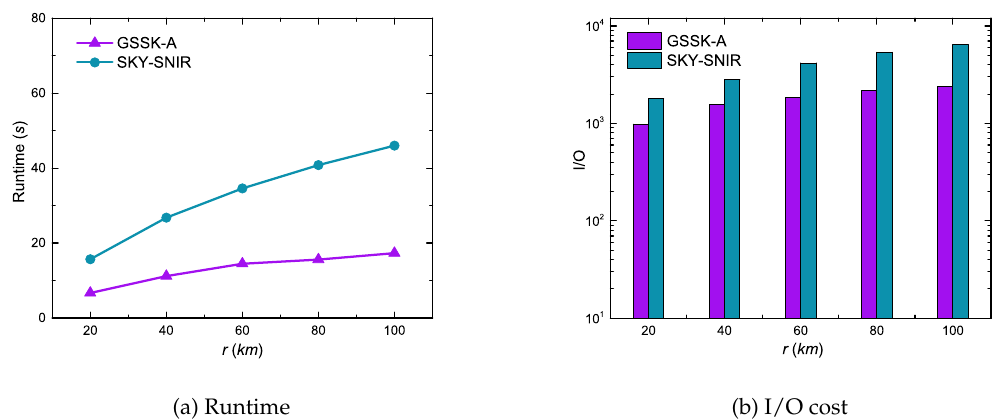
Figure 11. Effect of range on runtime and I/O cost.